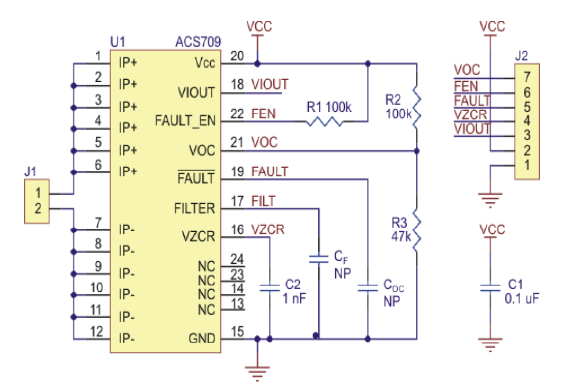
Figure 3. Electric current sensor schematic diagram